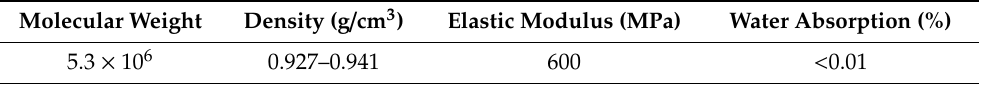
Table 1. Physical properties of the Ultra-high molecular weight polyethylene (UHMWPE)